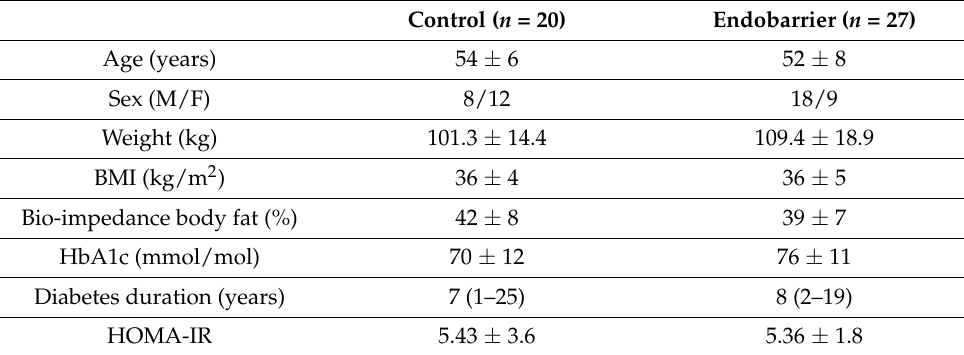
Table 1. Baseline characteristics of participants.